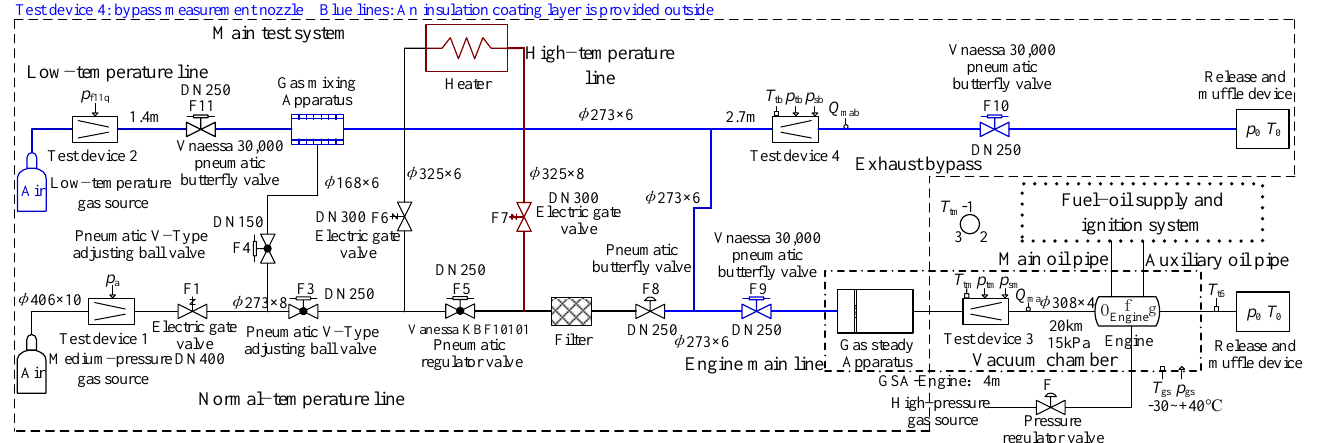
Figure 1. Schematic diagram of the core engine test rig system.